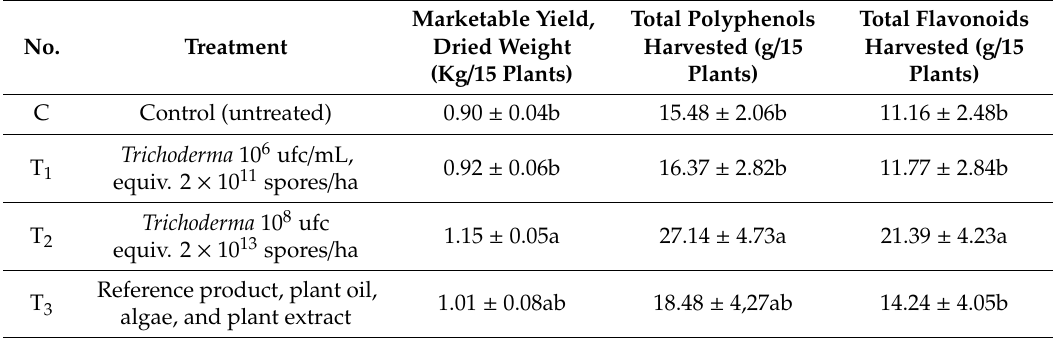
Table 2. Marketable dried yield of aerial plants, total polyphenols, and total flavonoids in the harvested biomass from the P. caerulea plants that were treated with the plant